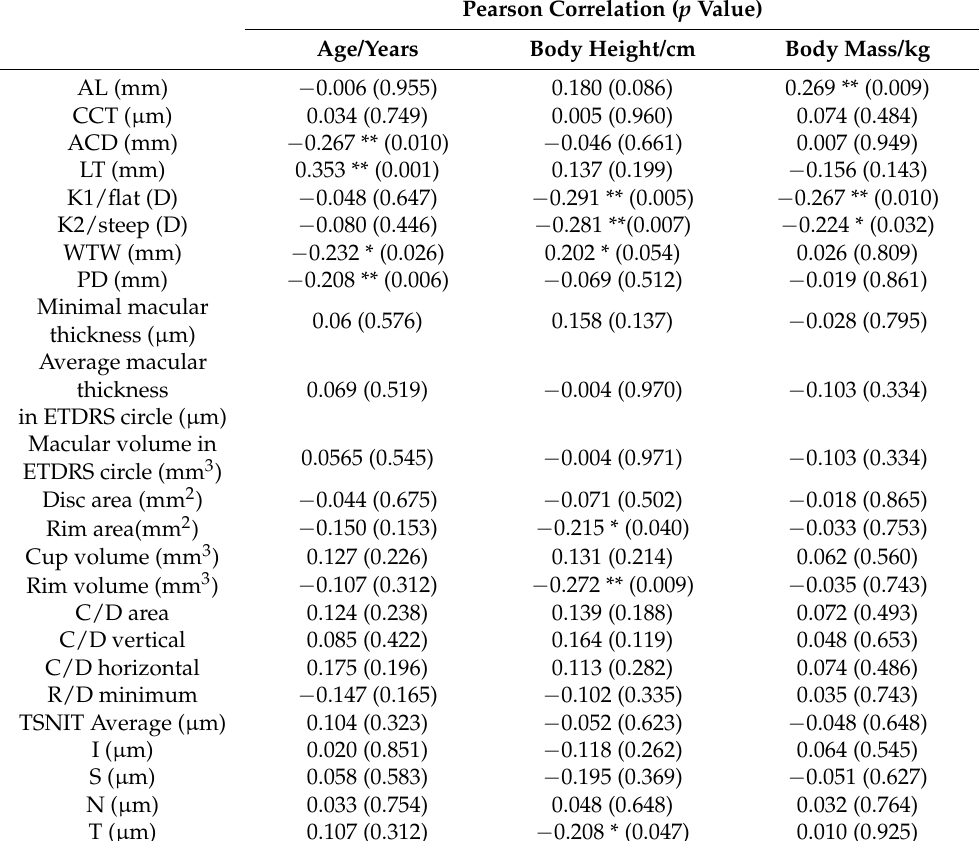
Table 2. The Pearson correlations of age, body height and body mass with eye biometric parameters in female (N = 92)